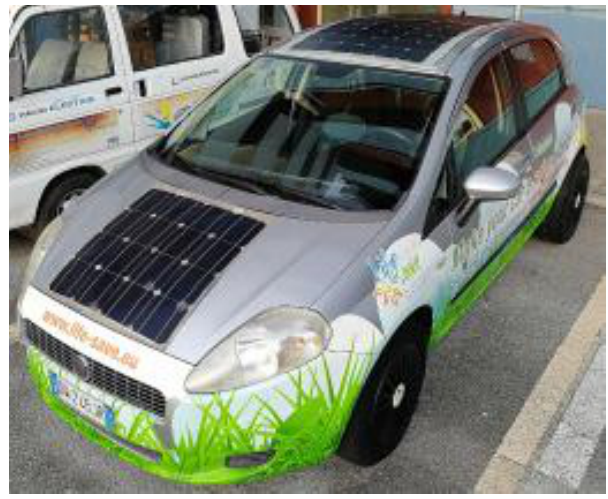
Fig. 7. Hybrid Solar Vehicle prototype [40]